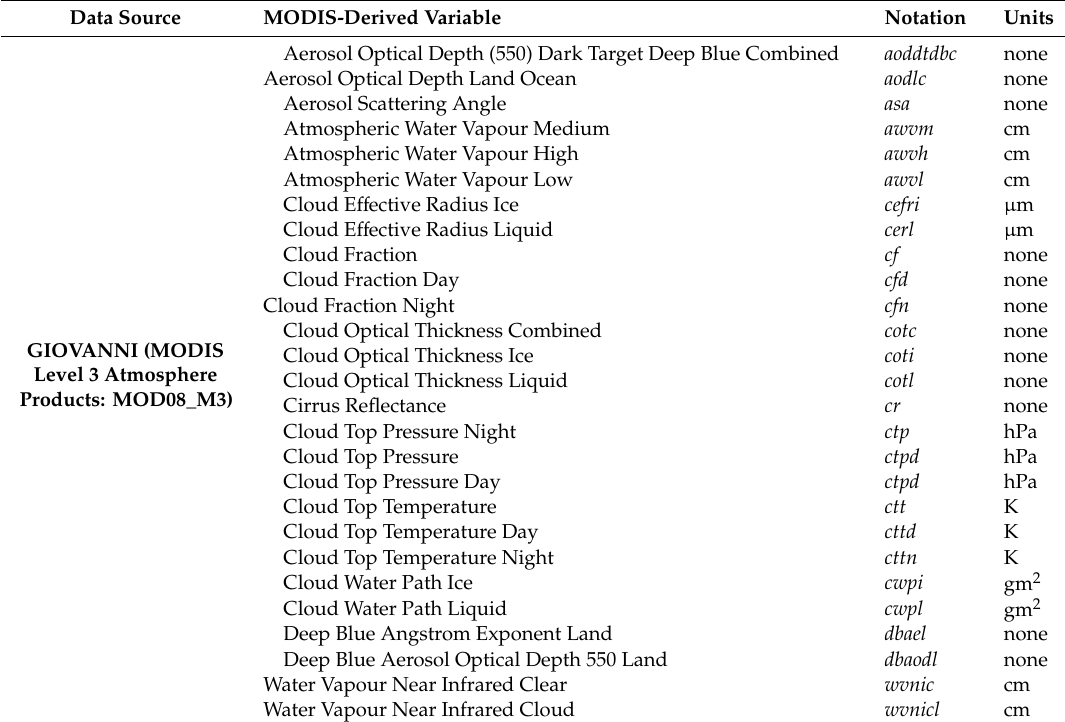
Table 1. Description of Moderate Resolution Imaging Spectroradiometer (MODIS) satellite-derived predictors, with the relevant notation adopted in this study to predict monthly averaged daily solar radiation ( GSR ) in Australia’s solar cities (data source: Goddard Online Interactive Visualization and Analysis Infrastructure (GIOVANNI) NASA